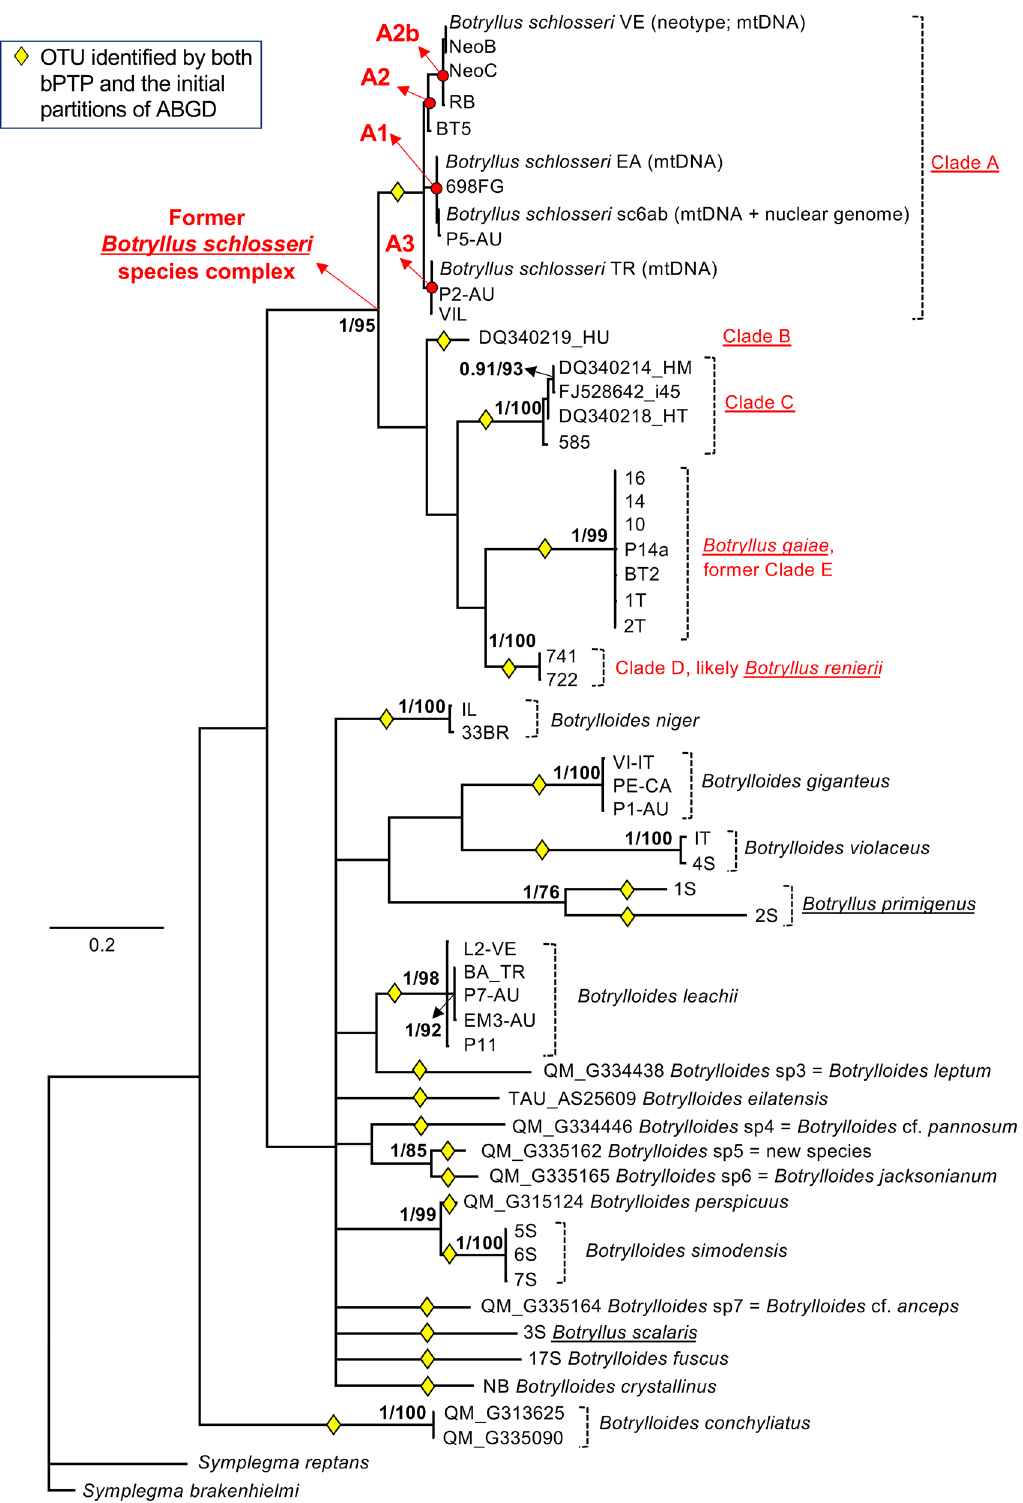
Figure 3. Bayesian majority rule consensus tree reconstructed from the "Folmer-524nt" alignment. Except for clade A, support values are reported close to the nodes as BPP/ML bootstrap percentage, only if BPP ≥ 0.90 or ML bootstrap ≥ 70%. Only for clade A, node supports are shown in Table 4. Yellow diamonds: OTUs identified by the initial partitions of all ABGD analyses (see “Methods”) and by bPTP; red dots: main sub-clades (A1, A2, A2b and A3) within clade A, described in Table 4; underlined names: genus Botryllus . The specimens of B. schlosseri clade A as neotype 39 or for which the entire mitochondrial or nuclear genomes were sequenced 31,66 are also